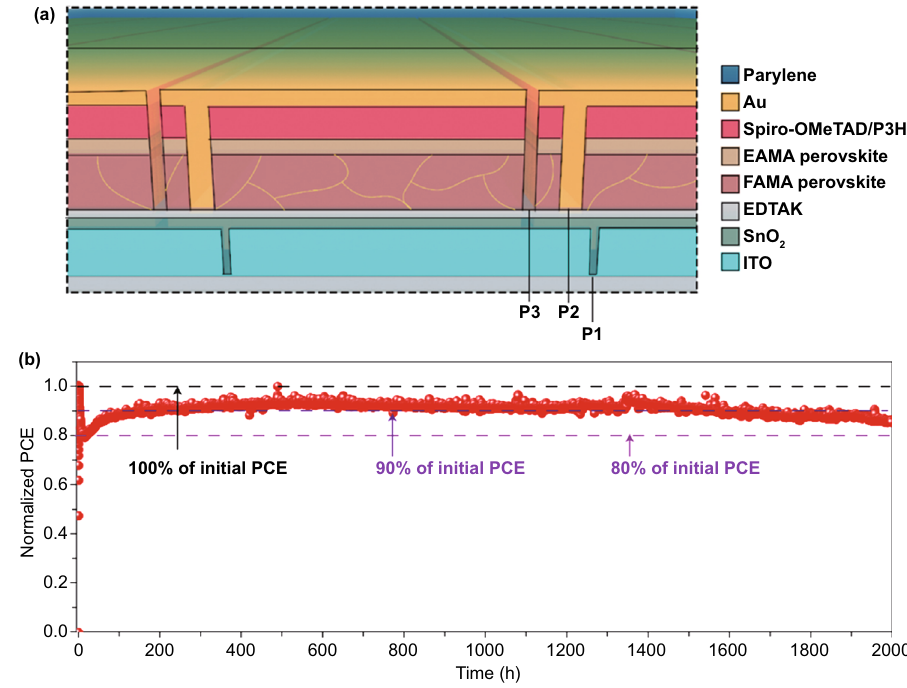
Fig. 4 a The holistic method containing four treatments for the functional layers and their interfaces in device, including the use of EDTAK to modify SnO 2 layer, the use of ethylammonium iodide (EAI) to form EAMA-based perovskite atop the FAMA-based perovskite absorber, doping P3HT into the spiro-OMeTAD layer, and using parylene to encapsulate the PSC module. b The operational stability of parylene-encapsulated solar module with a structure of SnO 2 -EDTAK/perovskite/spiro-OMeTAD-P3HT/Au measured under continuous 1-sun illumination. Repro- duced with permission from Ref. [47] Copyright 2020 Nature Publishing